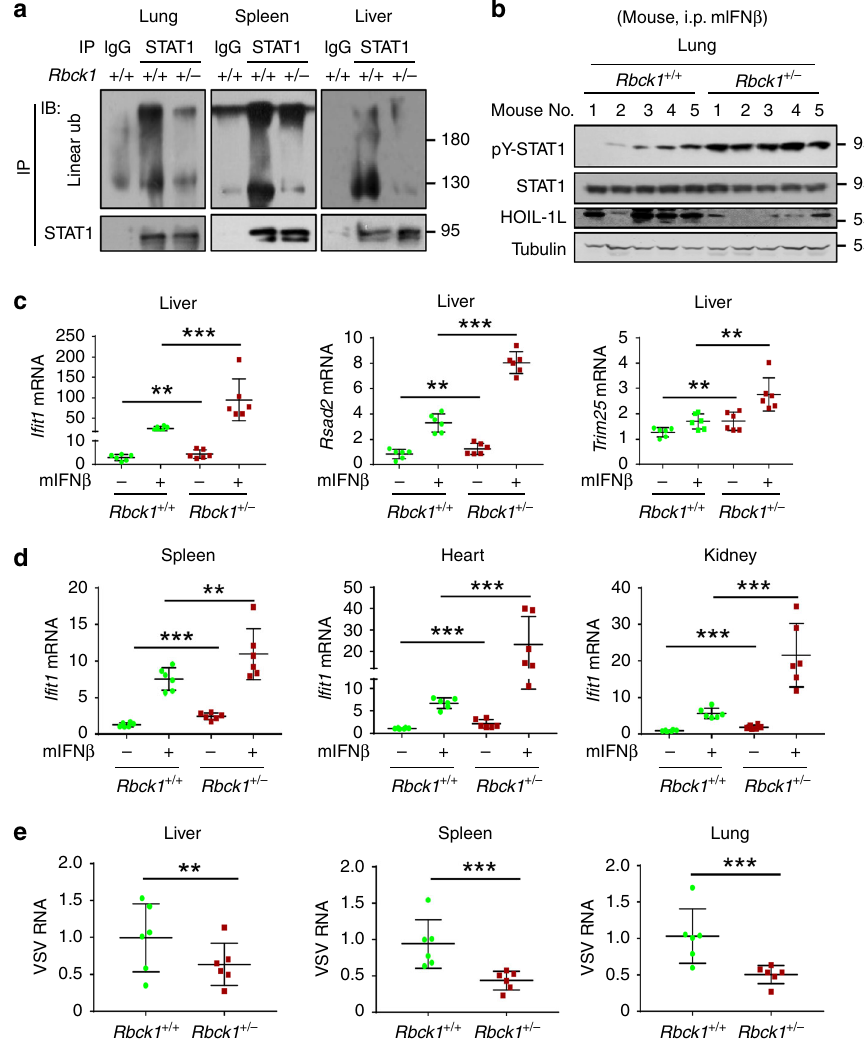
Fig. 7 Linear ubiquitination regulates IFN-I antiviral activity. a Immunoprecipitation analysis of linear ubiquitination of STAT1 in the lung, spleen, and liver tissues from Rbck1 + / + or Rbck1 + / − mice. b Western blot analysis of pY-STAT1 in the lung tissues from Rbck1 + / + or Rbck1 + / − mice administrated with mIFN β (1500 IU/g, i.p.) for 8h. c RT-qPCR analysis of the representative ISGs ( I fi t1 , Rsad2 , and Trim25 ) mRNA in the liver tissues from Rbck1 + / + or Rbck1 + / − mice administrated with mIFN β as b . d RT-qPCR analysis of a representative ISG ( I fi t1 ) mRNA in the spleen, heart, and kidney tissues from Rbck1 + / + or Rbck1 + / − mice administrated with mIFN β as b . e RT-qPCR analysis of VSV viral RNA in the liver, spleen, and lung tissues from Rbck1 + / + or Rbck1 + / −